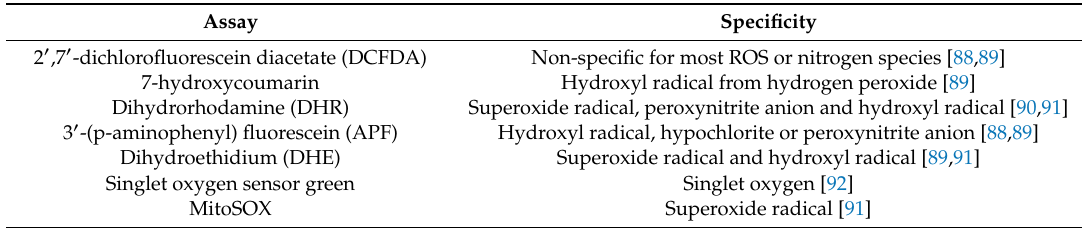
Table 1. Summary of fluorescence dyes assays for reactive oxygen species (ROS) measurement and their specificity.